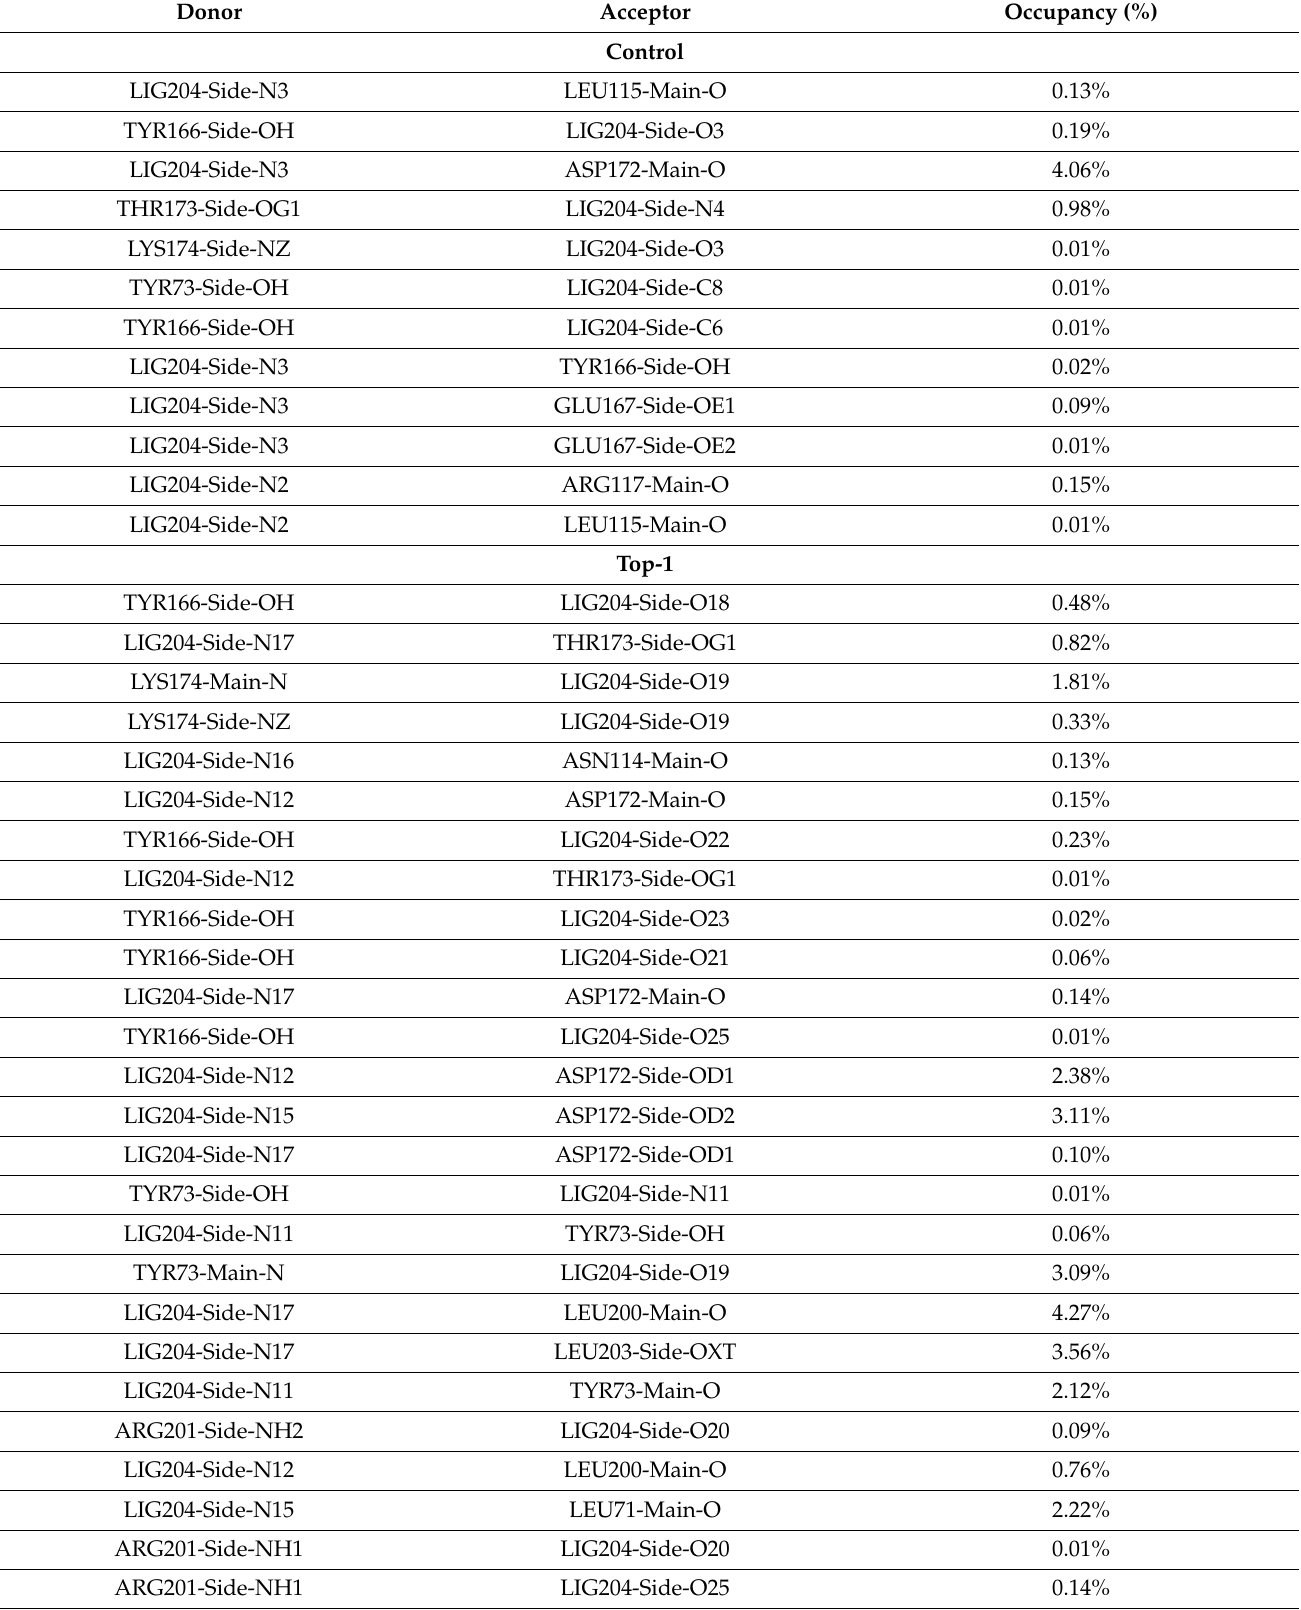
Table 2. Occupancy of hydrogen bonds formed between the leads and the MvfR